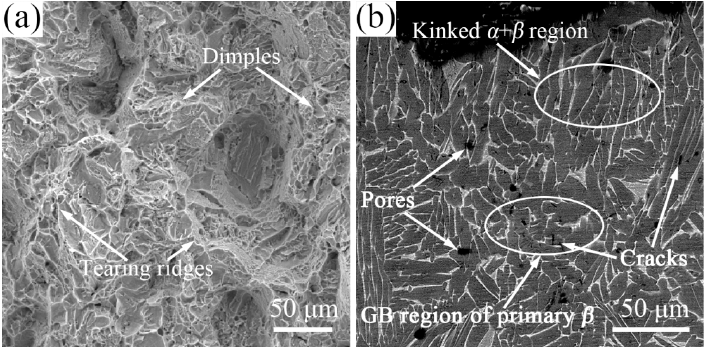
Table 5. Room-temperature tensile properties of the TiB(TiC)/TA15